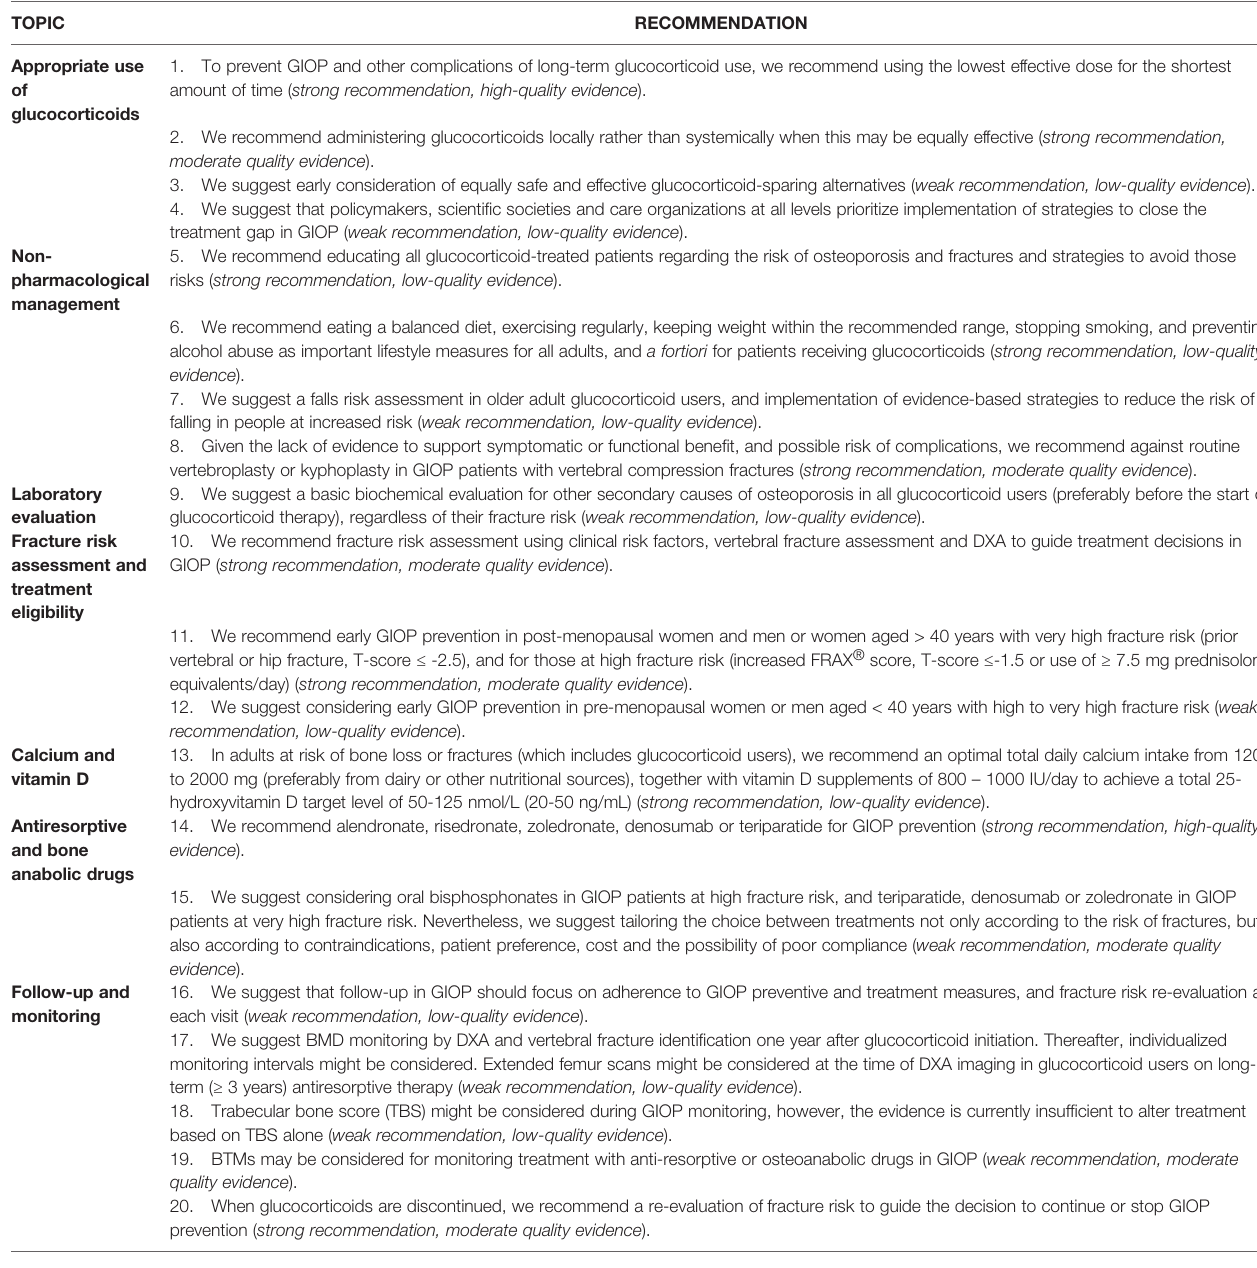
TABLE 2 | Summary of the BBC recommendations for GIOP in